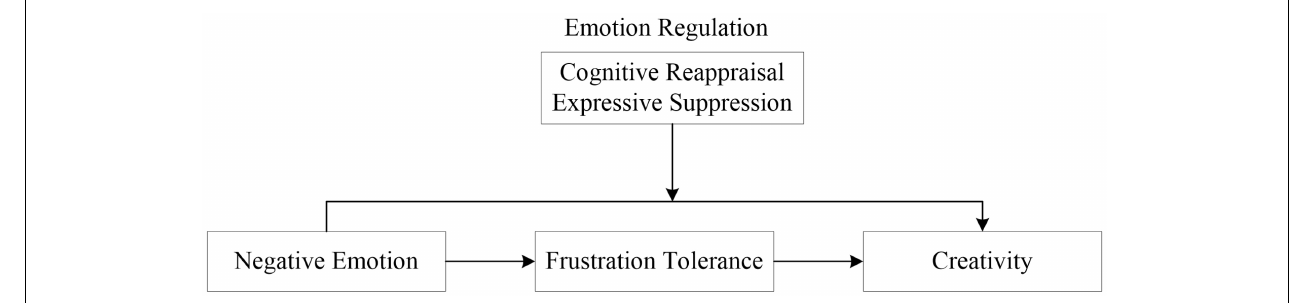
FIGURE 1 | The conceptual